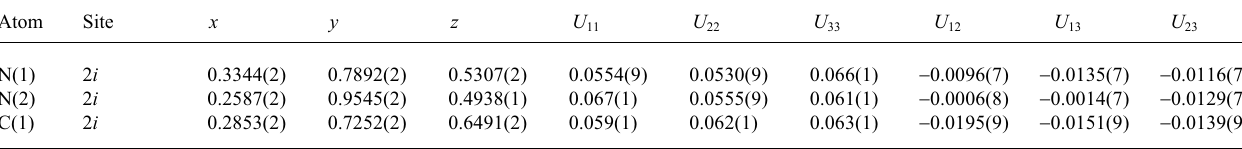
Table 3. Atomic coordinates and displacement parameters (in Å 2